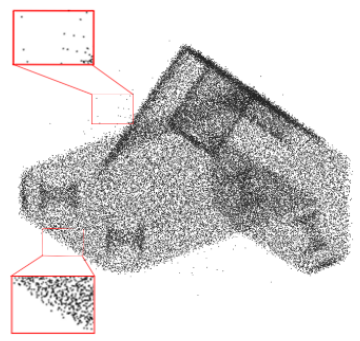
Figure 1. Point cloud model with Laplace noise and Gaussian noise.